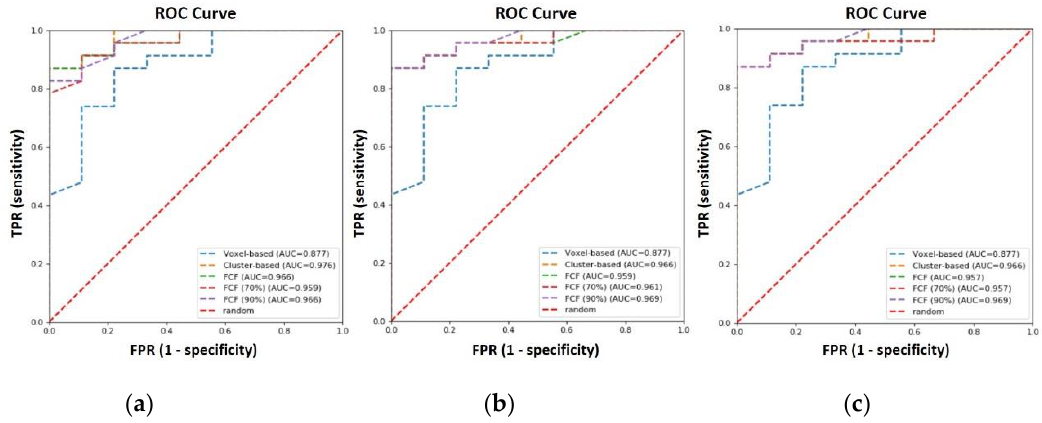
Figure 6. Receiver-operating characteristic (ROC) curves for voxel-based, cluster-based and Fit-Cluster-Fit models when applying different confidence thresholds (70% and 90%) to exclude uncertainties, and after performing a voxel-wise clusterization into two habitats with the ( a ) 5th, ( b ) 10th and ( c ) 15th percentiles as the parcellation thresholds.